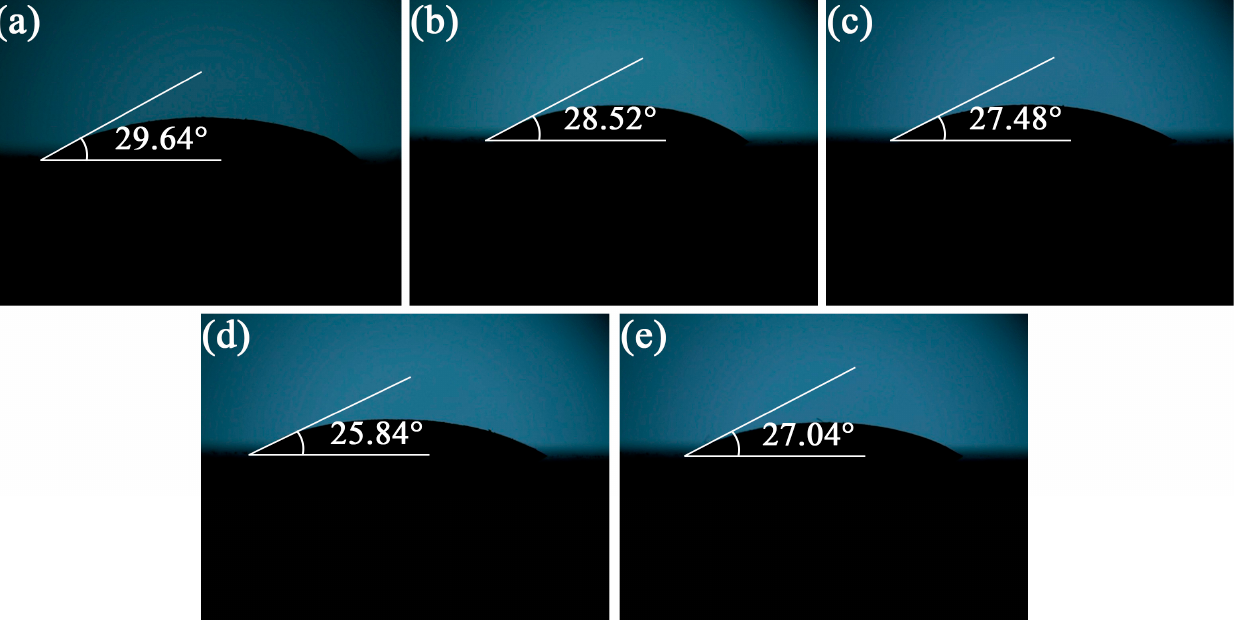
Figure 2. Wetting angle of ( a ) Sn-0.7Cu, wetting angle of Sn-0.7Cu-10Bi-xCr: ( b ) 0.05 wt.%, ( c ) 0.1 wt.%, ( d ) 0.2 wt.% and ( e ) 0.3 wt.%.